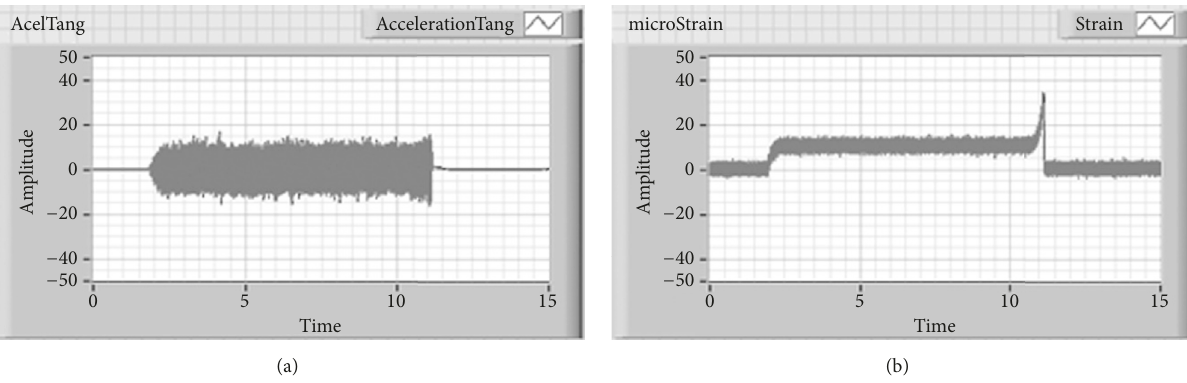
Figure 3: Acceleration and strain data of test 11.